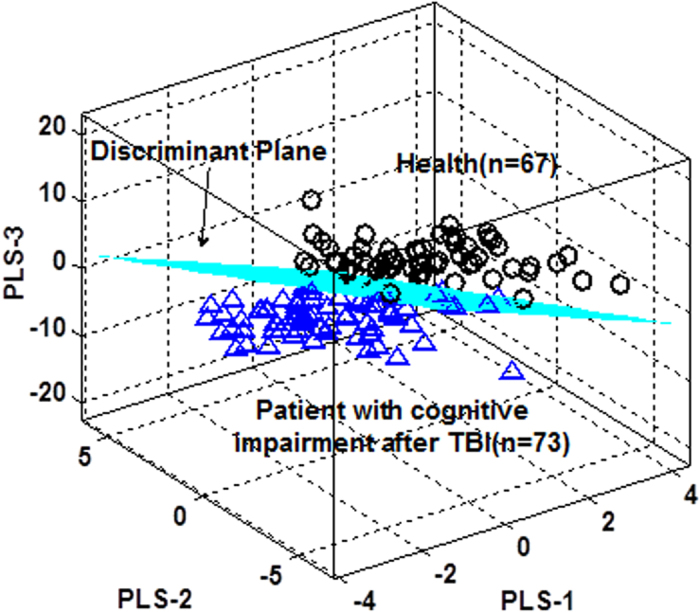
PLS-DA model to discriminate between TBI patients with cognitive impairment and healthy controls.